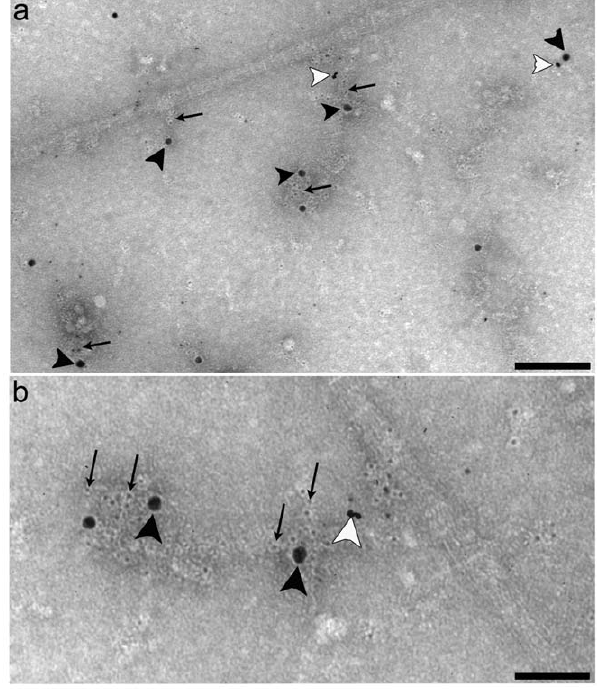
Figure 8. Analysis of collagen VI, WARP and perlecan in human articular cartilage. Immuno-gold EM was conducted on native supramolecular fragments isolated from human articular cartilage for WARP (18-nm gold particles; black arrowheads), perlecan (12-nm gold particles; white arrowheads) and collagen VI (6-nm gold particles, arrows). All three components are part of complexes at the suprastructural level (shown in a). The magnified image (shown in b) shows these complexes in close contact to banded collagen fibrils. Scale bars: 100 nm (panel a) and 200 nm (panel b).